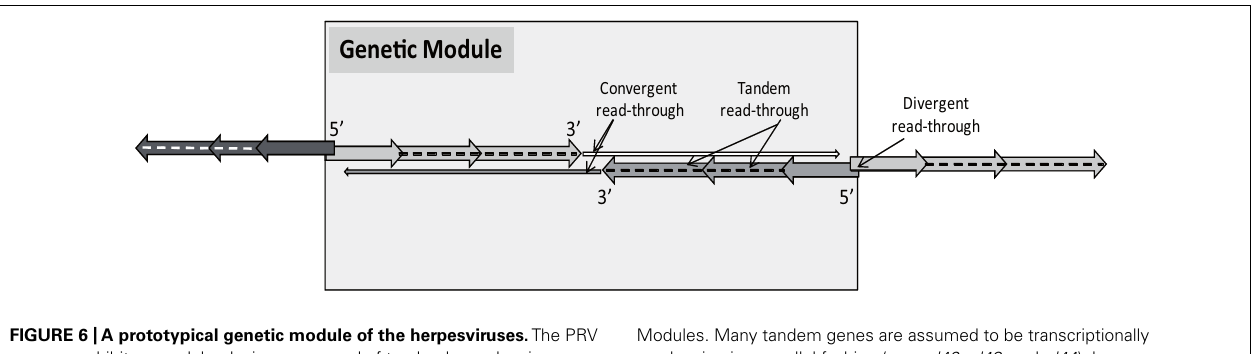
FIGURE 6 |A prototypical genetic module of the herpesviruses. The PRV genome exhibits a modular design composed of tandemly overlapping genes, as opposed to another tandem gene cluster in the prototypical Genetic